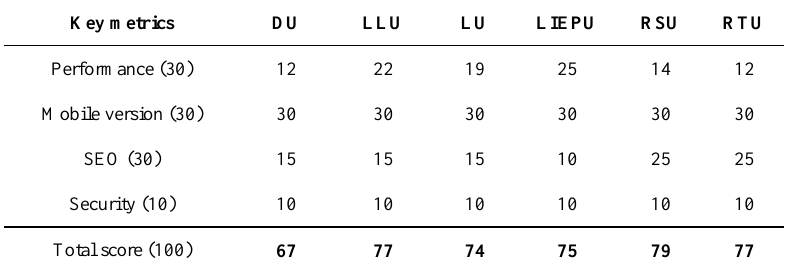
Table 2. Assessment of Latvia public universities’ websites according to Website Grader,